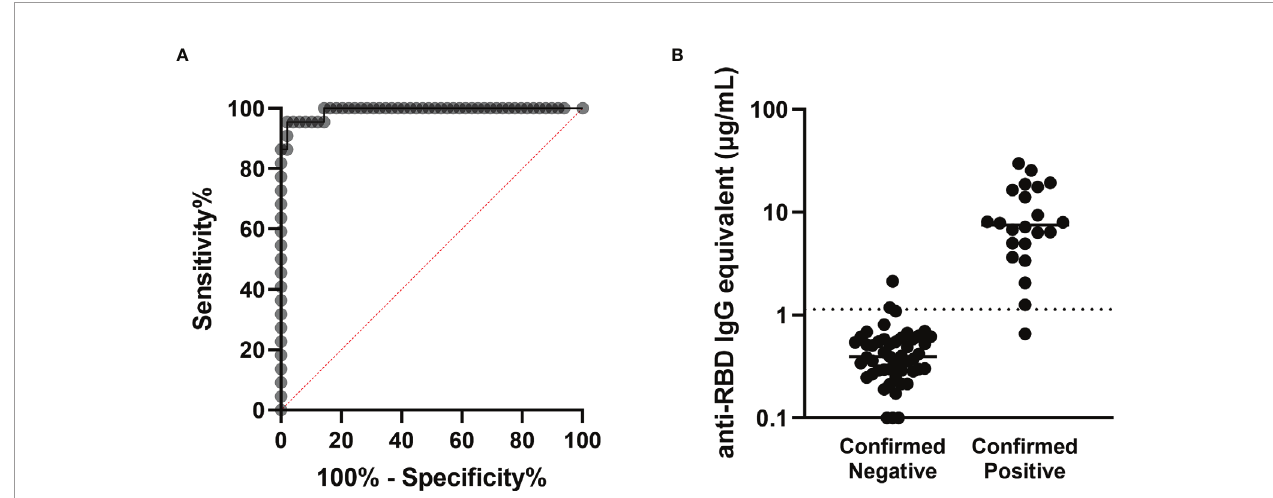
FIGURE 1 | Determination of the antibody concentration threshold based on the validation cohort. (A) ROC analysis based on the 22 con fi rmed positive and 49 con fi rmed negative sera comprising the validation cohort. The area under the curve is 0.9917 (**** p < 0.0001), and the sensitivity and speci fi city of this assay were determined to be 95.5% and 95.9% respectively, with the threshold between negative and positive set at 1.139µg/mL. (B) Anti-RBD antibody concentrations are shown for each participant in the validation cohort, sorted into negatives and positives based on prior con fi rmed COVID-19 status. The threshold is marked with the horizontal dotted